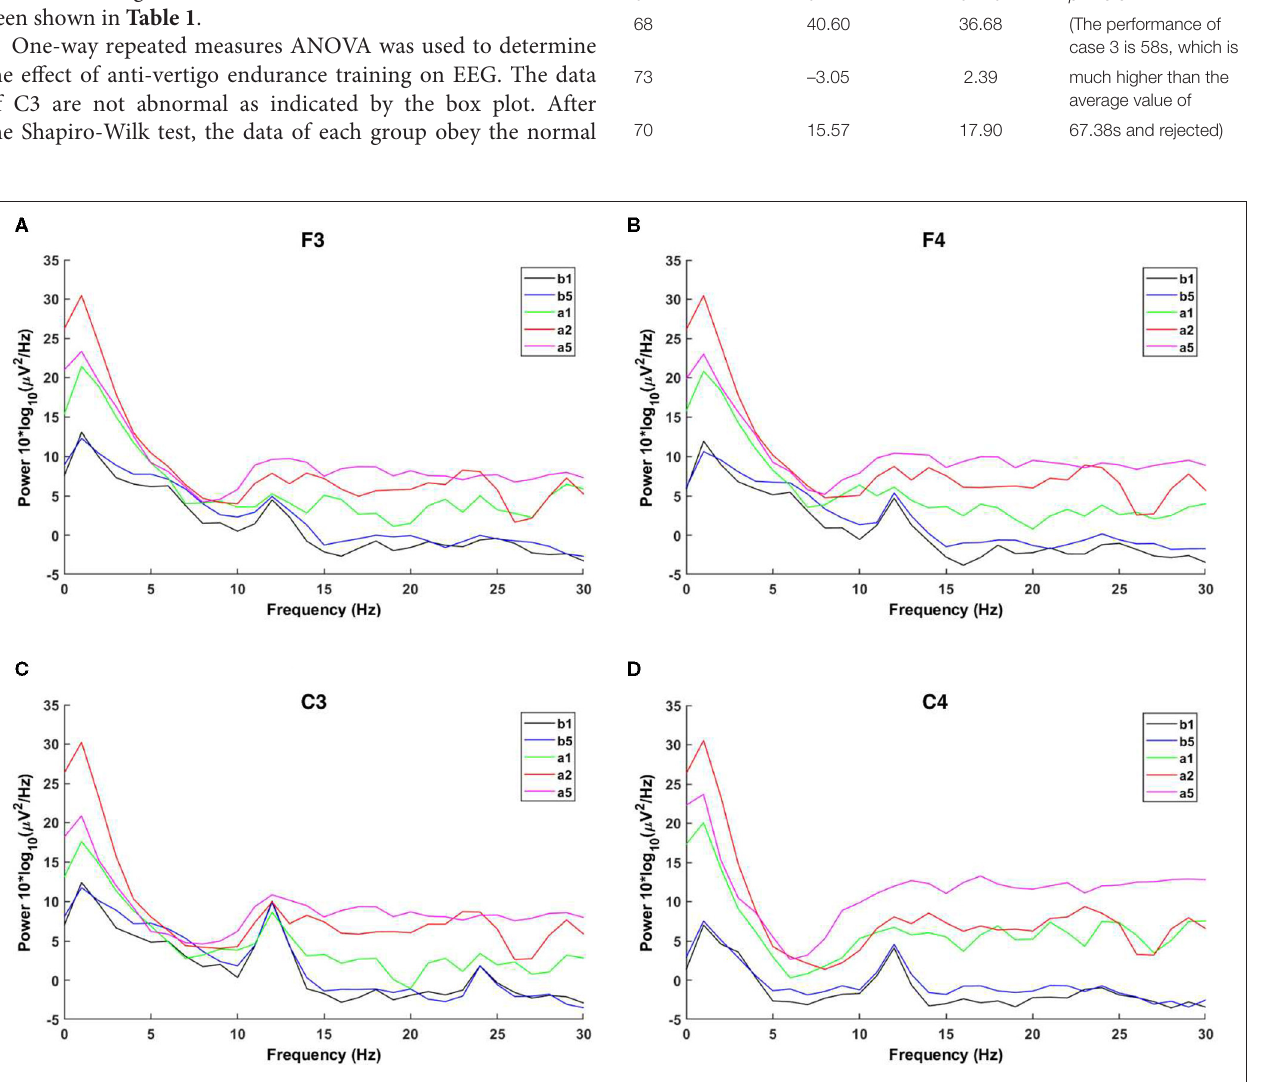
Frontiers in Human Neuroscience |